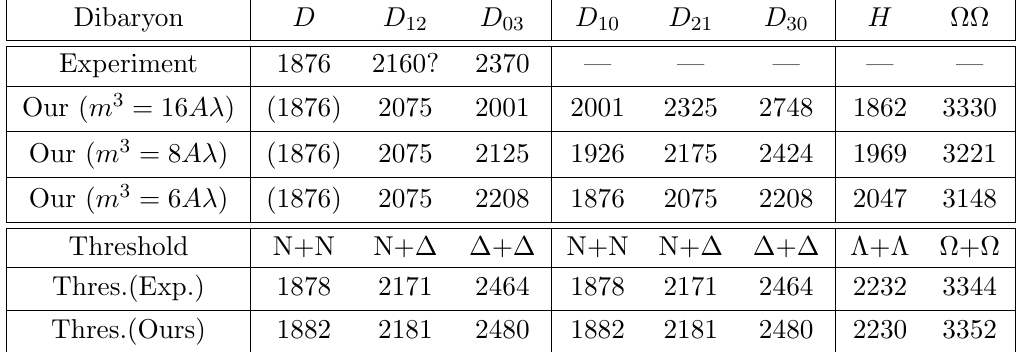
Table 12 . A numerical (cid:12)t of the hyperon and dibaryon spectrum by our formula (5.12). Since the deuteron mass is the only input for dibaryons, it trivially agrees with observation. The mass of D 03 in the recent experiment [84, 85] is 2370 MeV. Signal of D 12 is also observed around 2160 MeV though it is not very clear if it is a bound state.